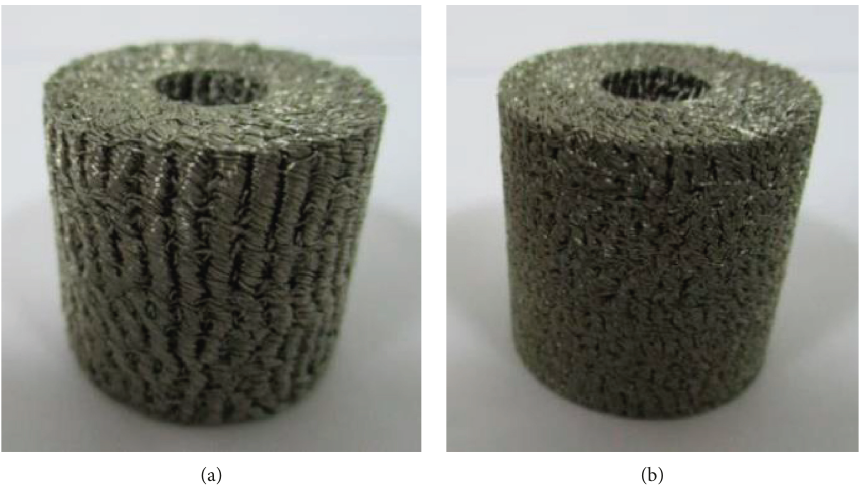
Figure 7: MR specimen with different densities. (a) ρ